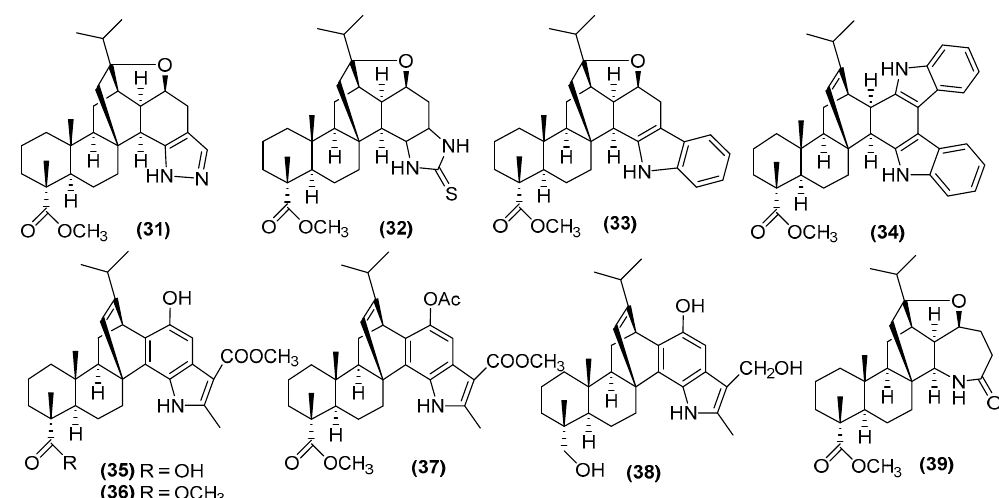
Figure 3. Structures of quinopimaric acid heterocyclic derivatives 31 – 39 .